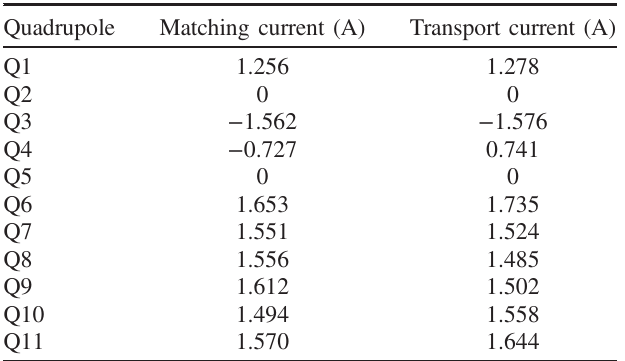
TABLE II. Experimental quadrupoles ’ current settings for the two different matching and transport conditions. The positions of the quadrupoles are those shown in Fig.